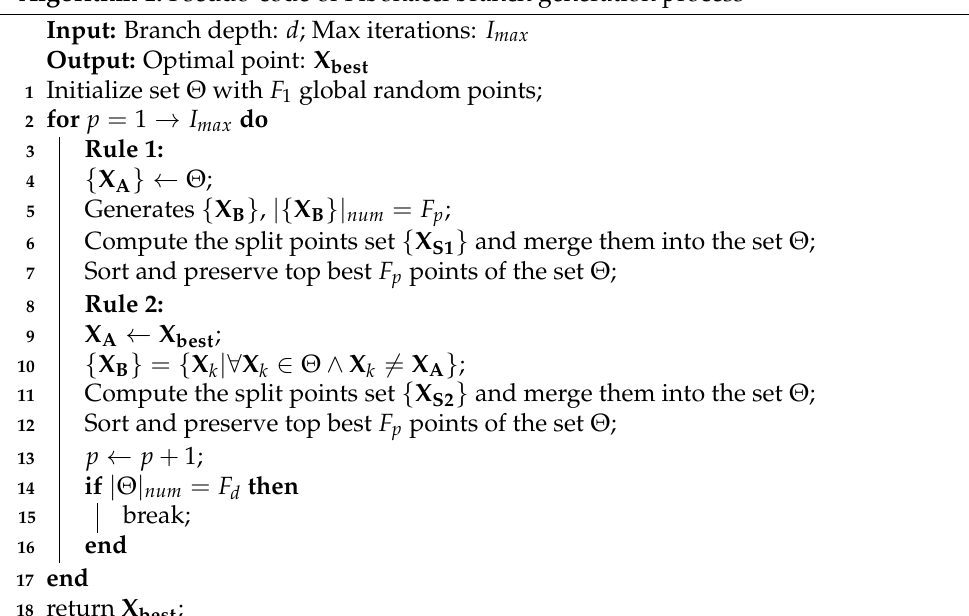
Figure 5. The diagram of the branch generation process in the Fibonacci tree optimization algorithm. The pseudo-code for the Fibonacci branch generation process is shown as Algorithm 1. Algorithm 1: Pseudo-code of Fibonacci branch generation